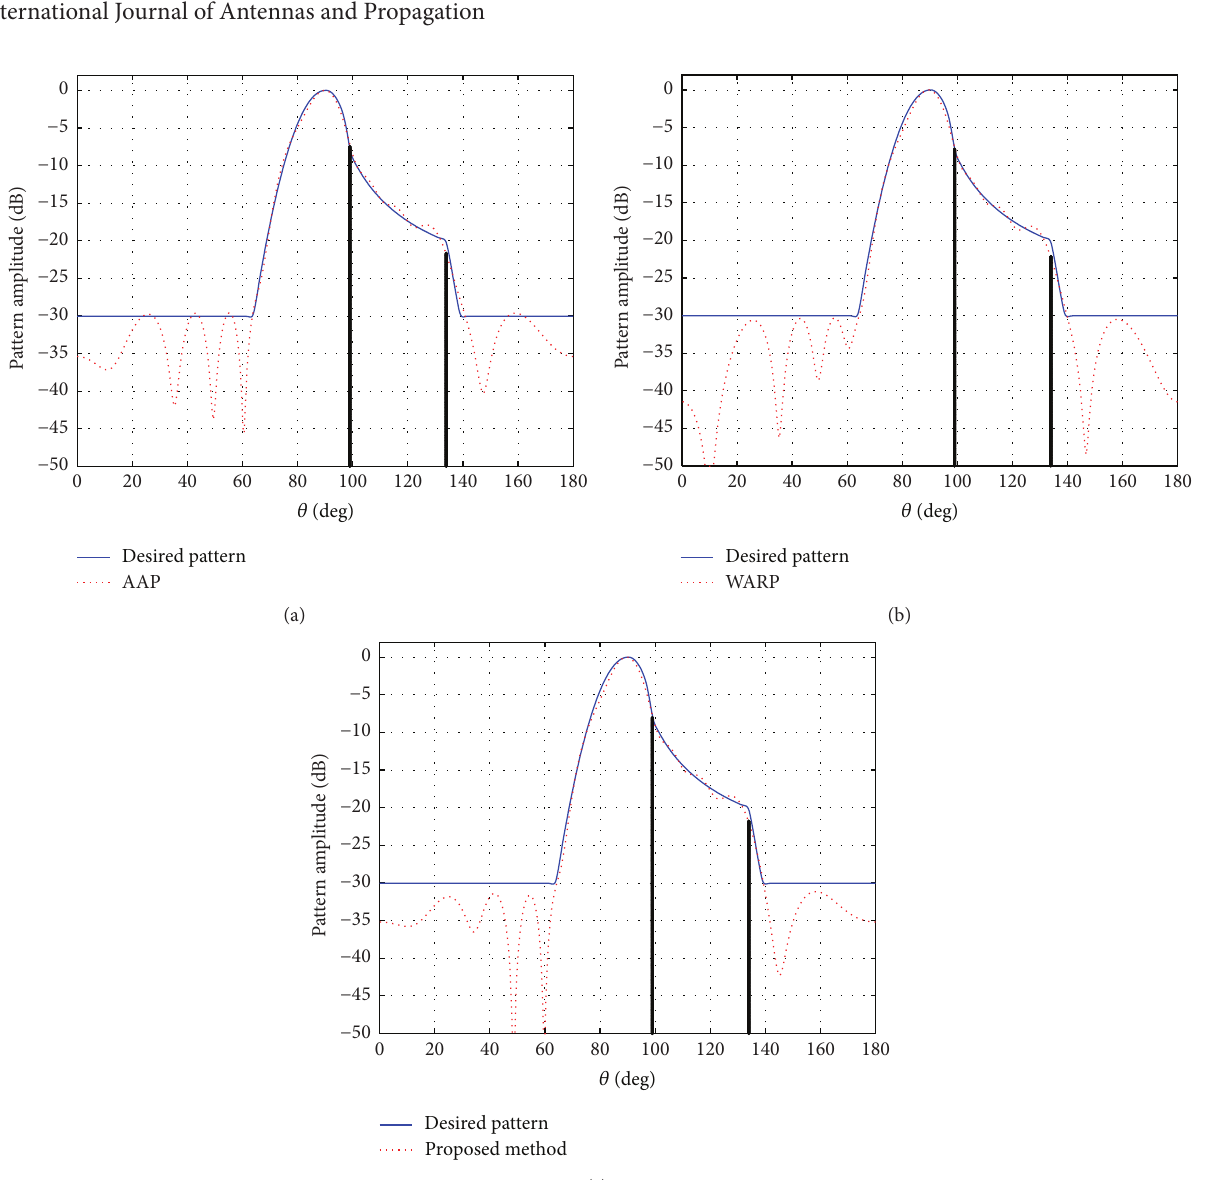
optimum pattern and excitation scaling factors. 𝑁 and